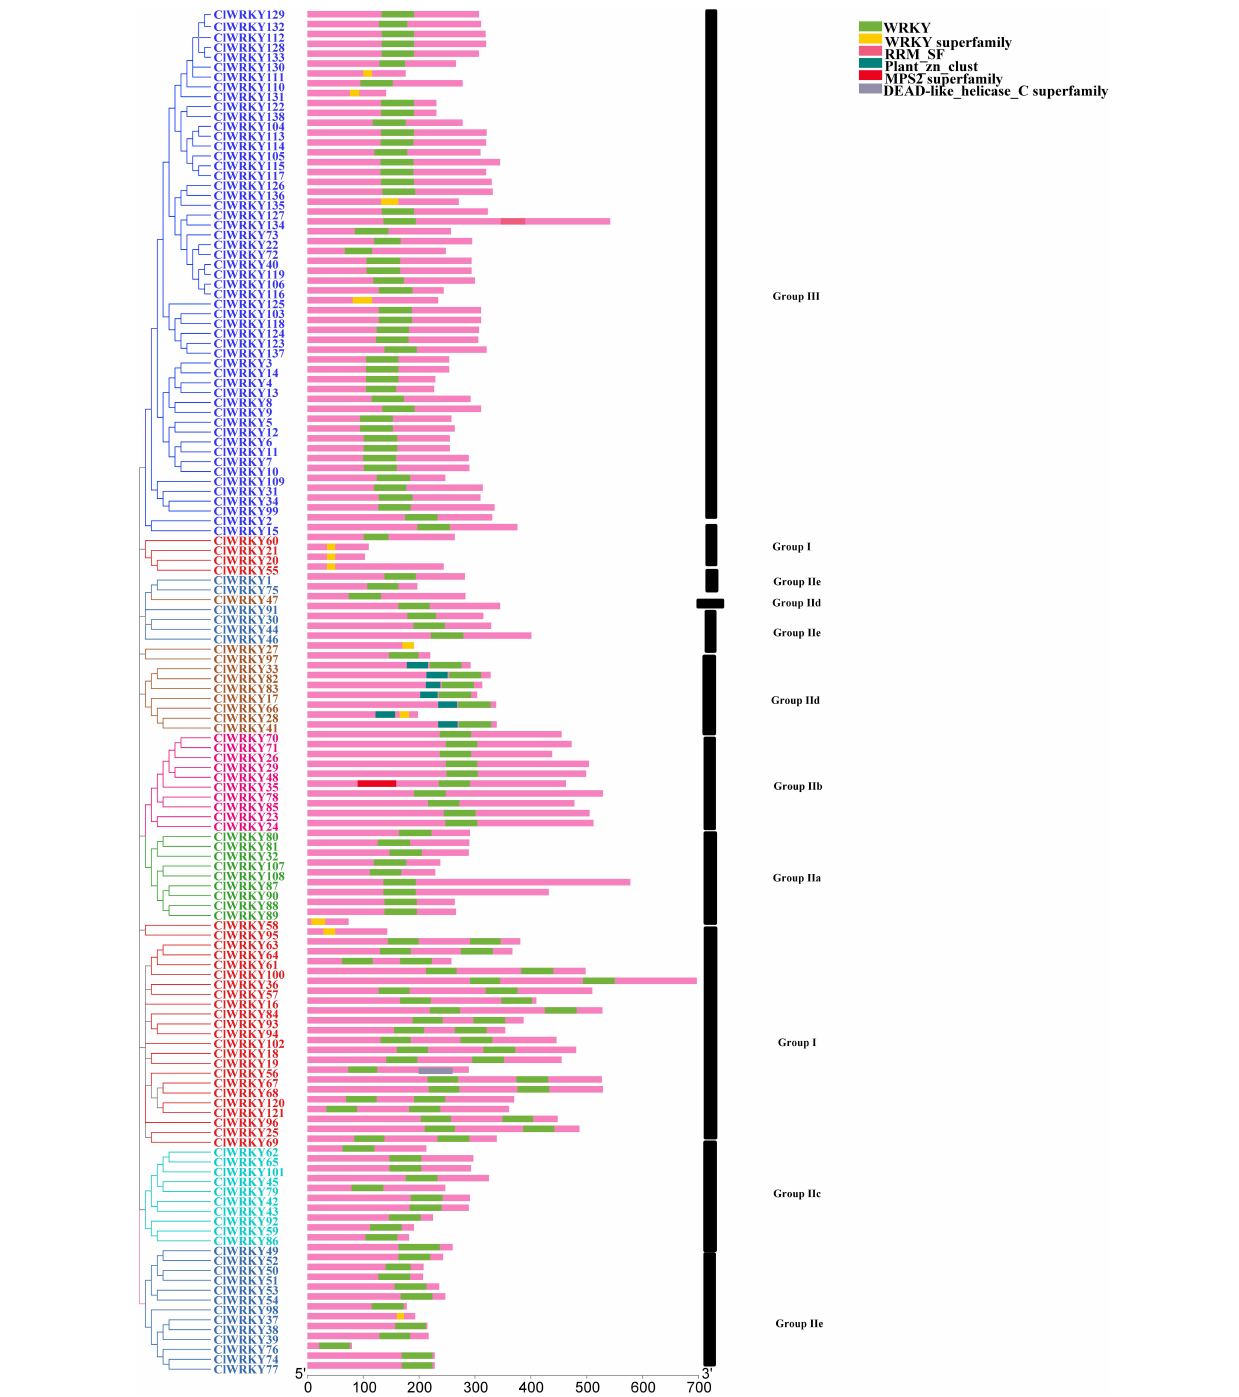
has been largely demonstrated (Yamasaki et al., 2005; Brand et al., 2013; Rinerson et al., 2015; Yang et al., 2020); however, variations in aa sequence were different from our findings. The variation